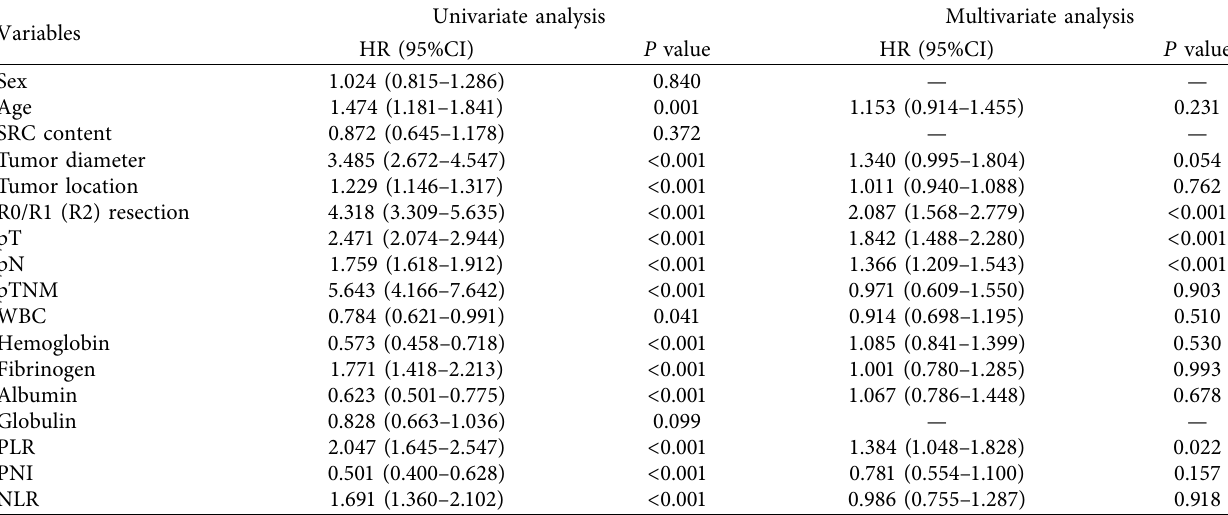
Table 4: Univariate and multivariate cox regression analysis for